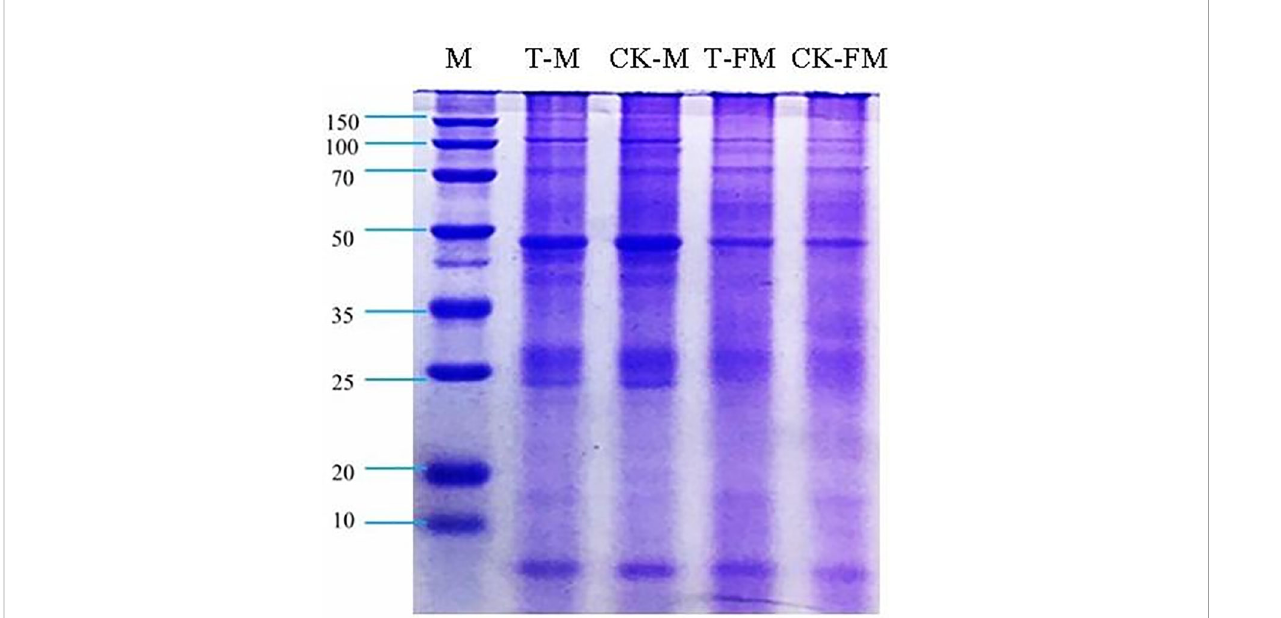
FIGURE 3 SDS-PAGE of adult schistosome proteins. T-M: Male adult schistosomes ( O. weishan ); CK-M: Male adult schistosomes ( O. hupensis ); T-FM: Female adult schistosomes ( O. weishan ); CK-FM: Female adult schistosomes ( O. hupensis